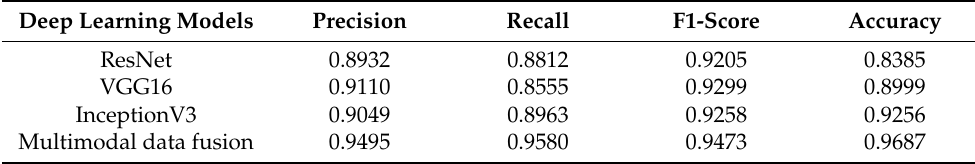
Table 4. Performance metrics comparison of the deep learning models.